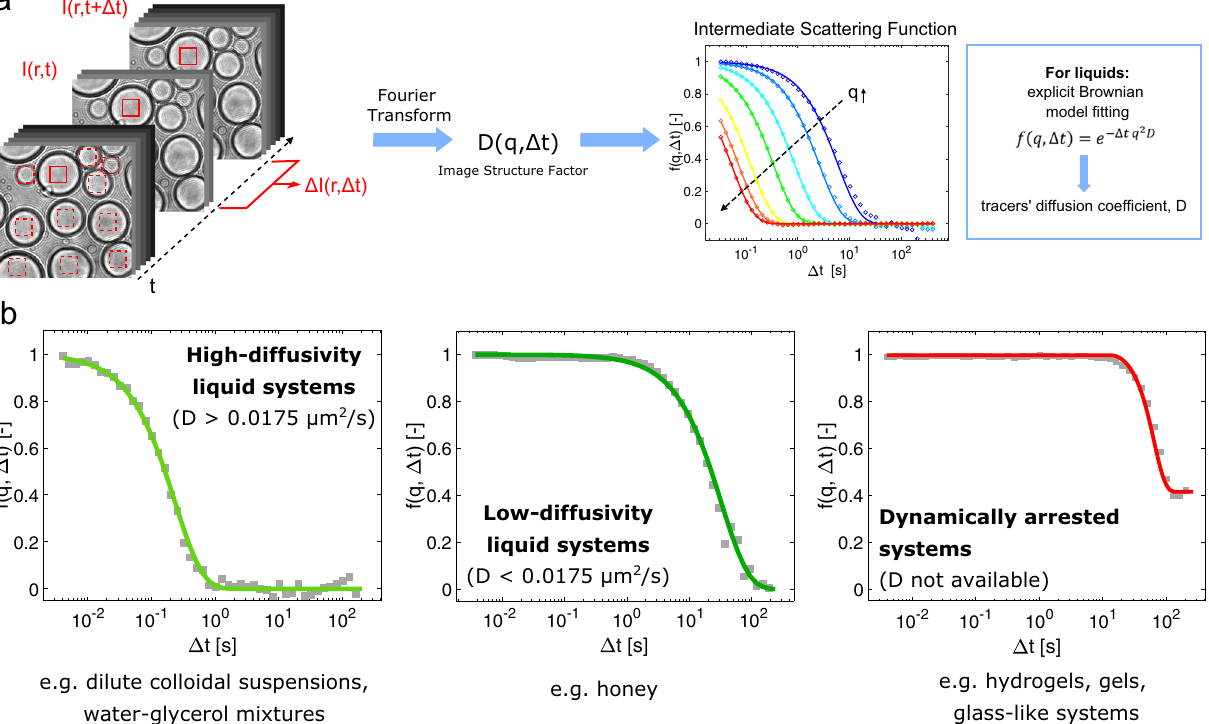
Fig. 3 Differential dynamic microscopy to assess the material properties of biomolecular condensates. a Schematic representation of the DDM technique. b Representative intermediate scattering functions (ISF, f ( q , Δ t )) for high-diffusivity liquid systems (water), low-diffusivity liquid systems (honey), and dynamically arrested systems (polymer-based hydrogel). Source data for panel b are provided in the Source Data fi